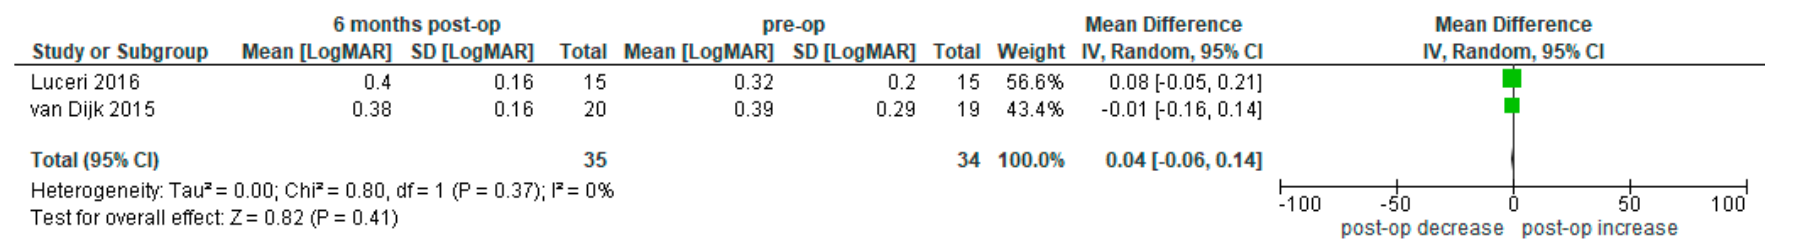
Figure A7. Difference in best spectacle-corrected visual acuity across 2 studies [31,36].